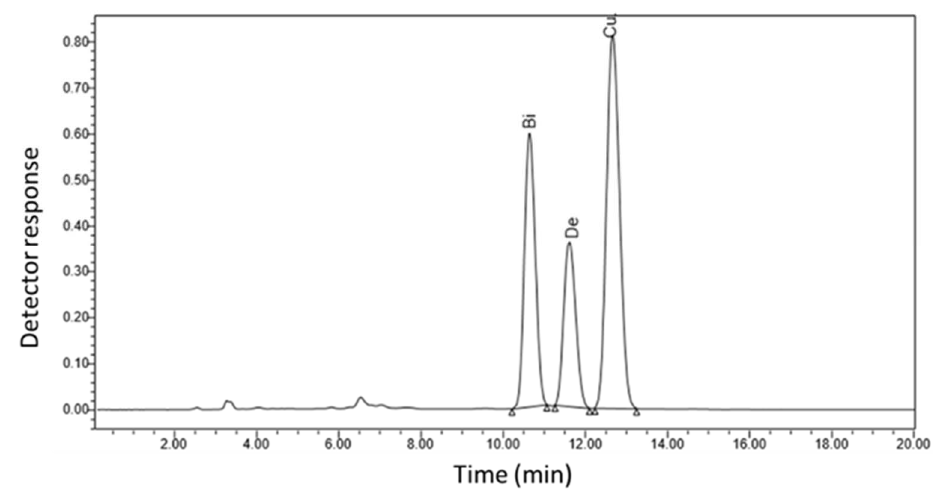
Figure 1. HPLC chromatogram of organic extract of C. longa exposed to 10 − 3 M SA, showing the curcuminoid compounds bisdemethoxycurcumin (Bi), demethoxycurcumin (De), and curcumin (Cu).